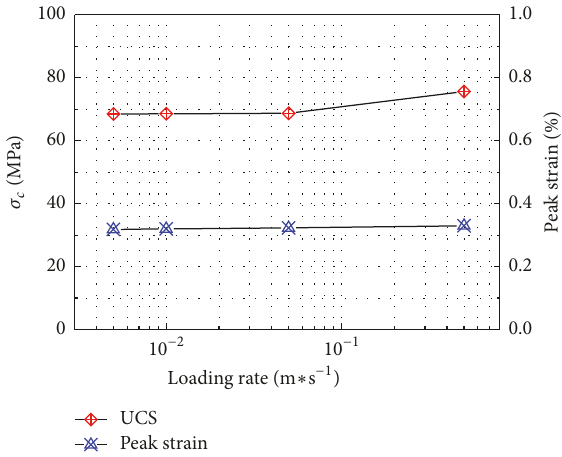
Figure 5: Schematic diagram of biaxial compression test.